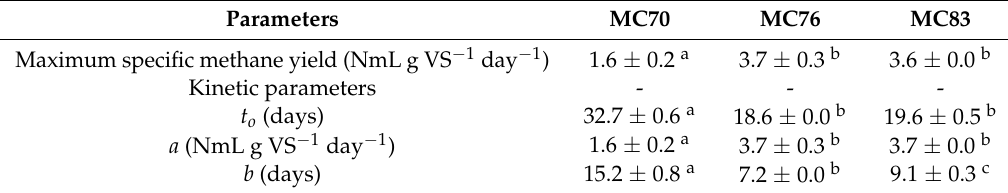
Table 3. Influence of initial feedstock moisture content on Gaussian parameters for specific methane yield from dairy manure. ( a,b,c Values are means ± SE, n = 3. Means with different superscripts are significantly different ( p < 0.05)).